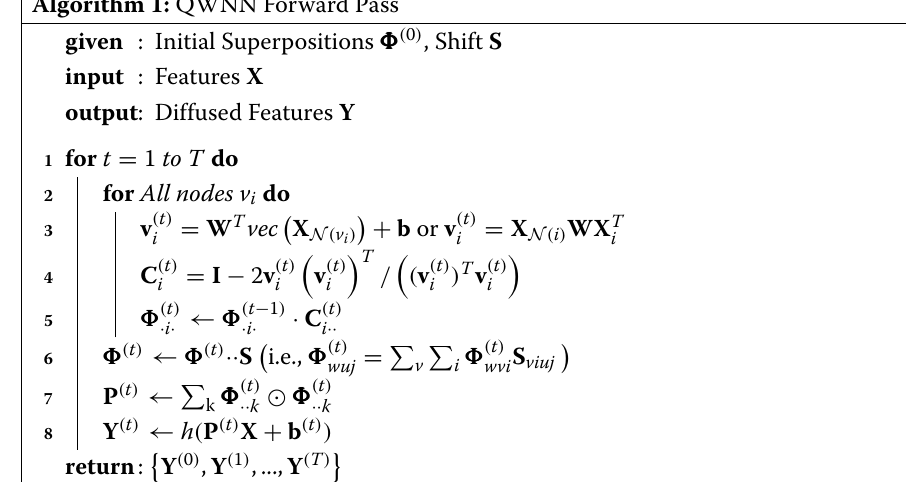
Algorithm 1: QWNN Forward